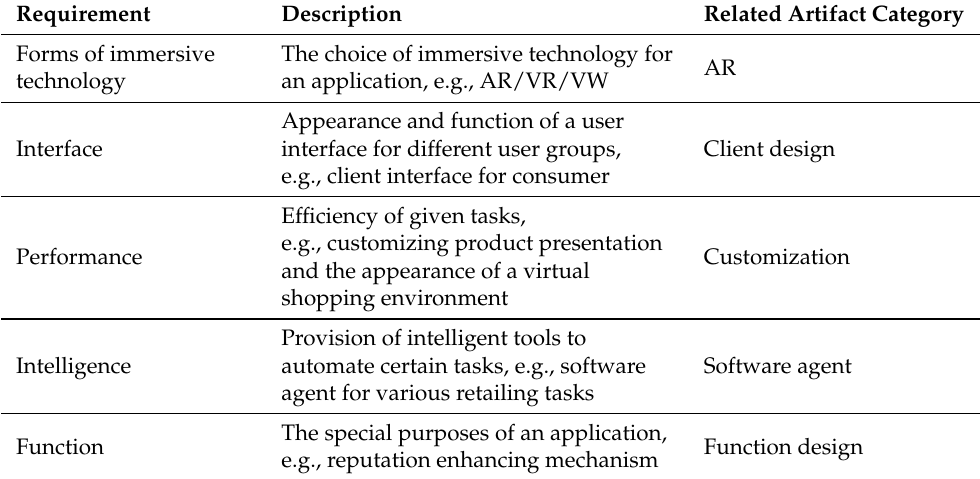
Table 10. Design requirements and related design artifact